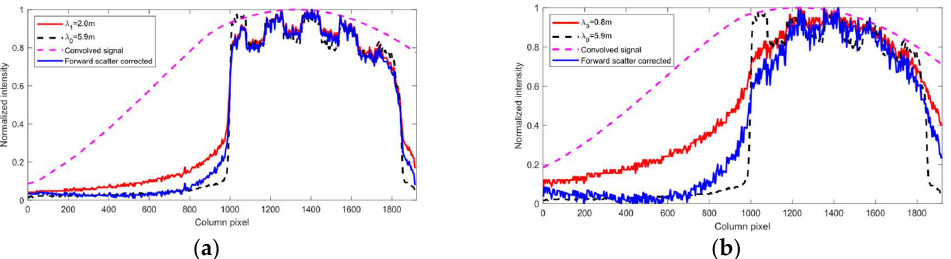
Figure 5. Forward scatter adjustment by unsharp filtering of the signal shown in Figure 4. ( a ) Turbidity 𝜆 (cid:2869) = 2.0 m , 𝜃 (cid:3047) = 0.25, 𝜌 (cid:3047) = 1. ( b ) Turbidity 𝜆 (cid:2871) = 0.8 m , 𝜃 (cid:3047) = 0.6, 𝜌 (cid:3047) =